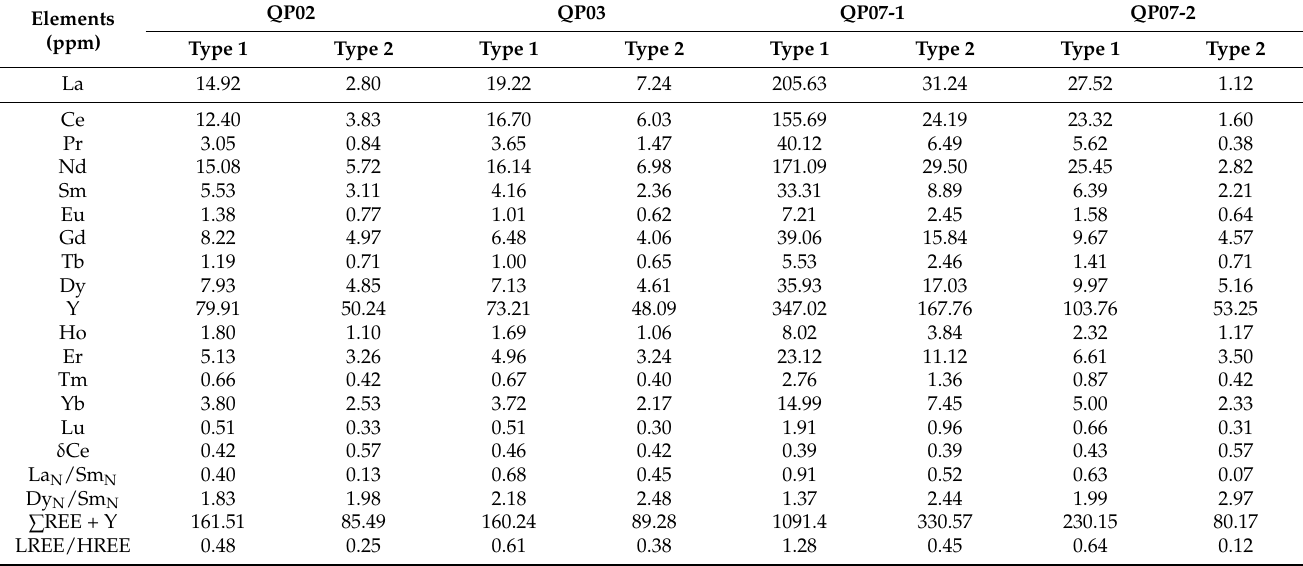
Table 5. Rare earth elements’ contents in different regions of apatite.